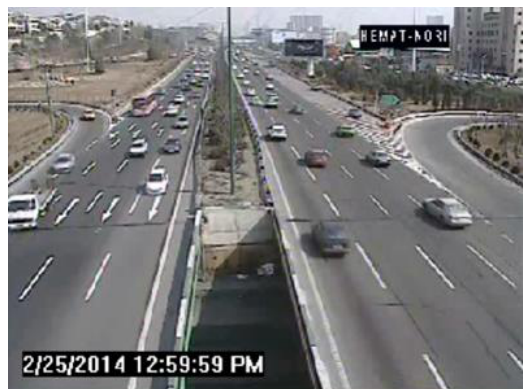
Figure 5: A frame of the CCTV footage.